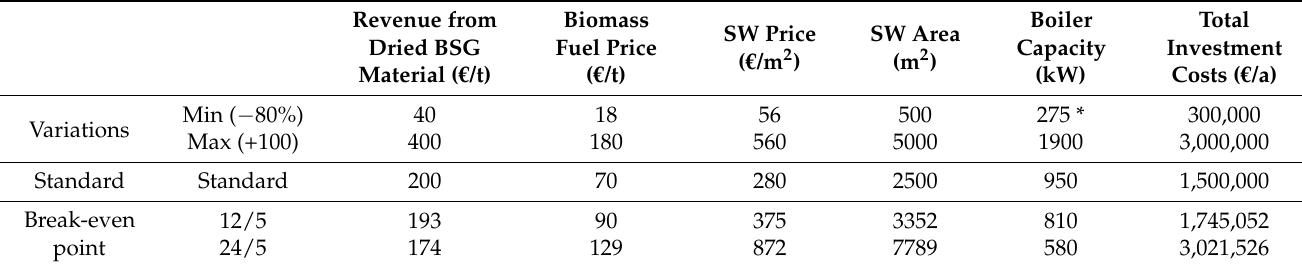
Table 8. Minimum, maximum, and break-even from the annuity calculation and sensitivity analysis of reference plant design (2500 m 2 , 950 kW) for both operational strategies 12/5 and